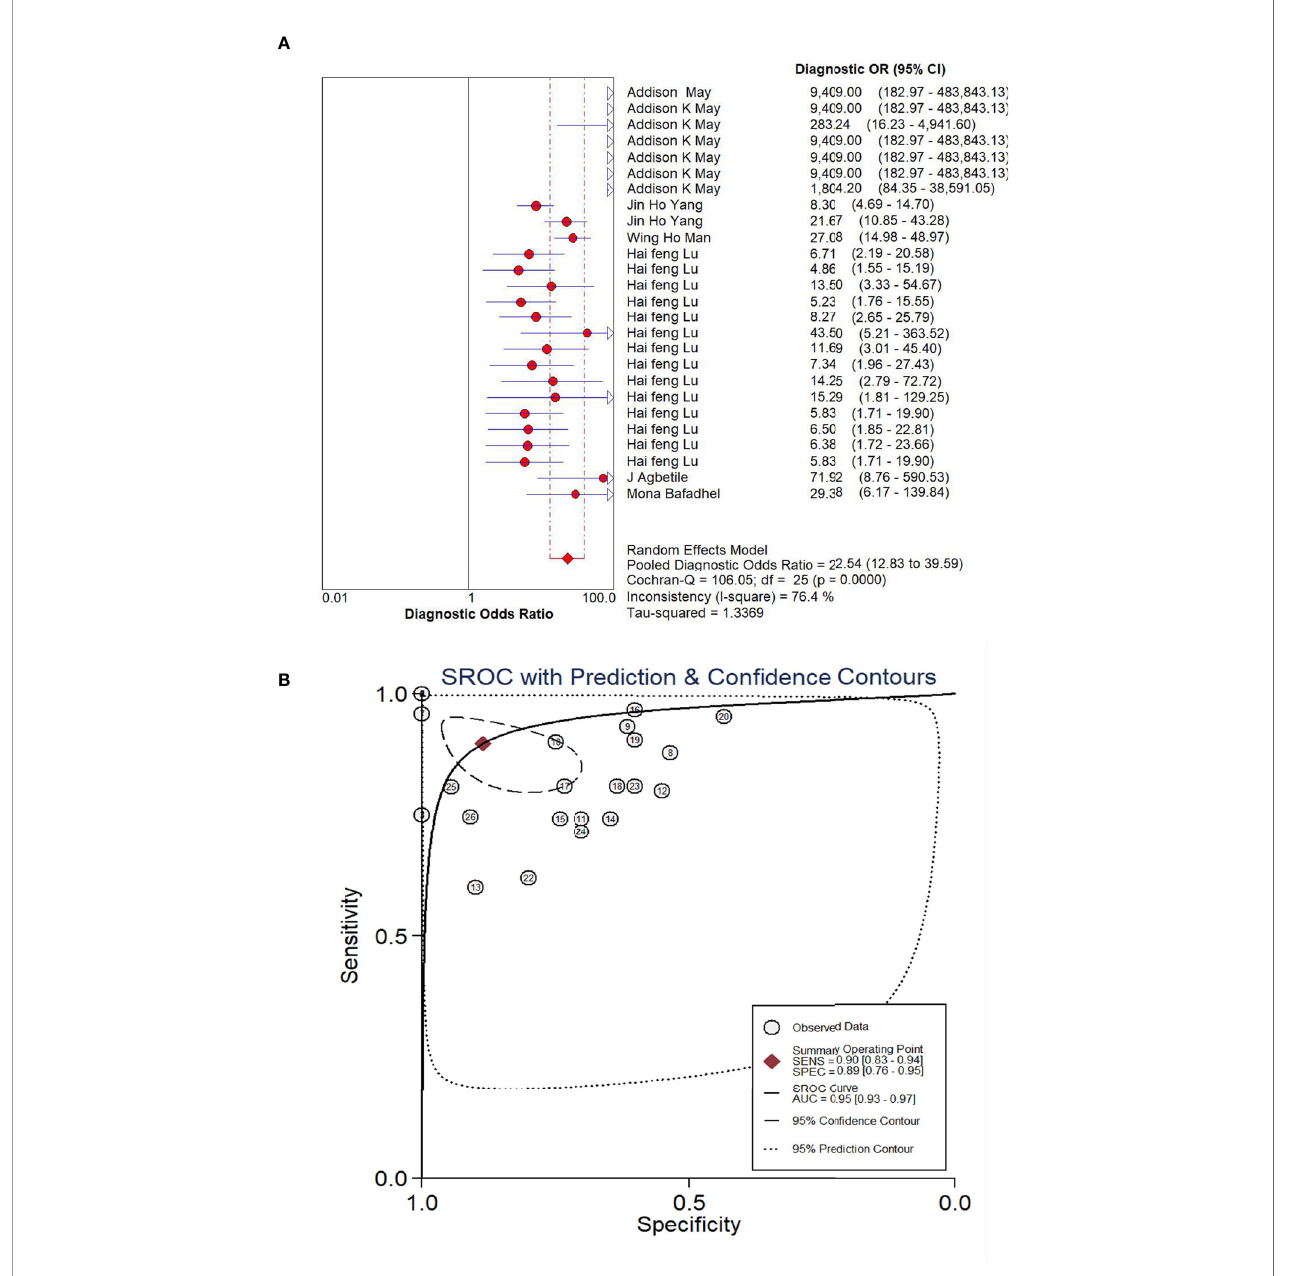
FIGURE 4 | Forest plot of DOR (A) and SROC (B) of microbiota biomarkers for the diagnosis of lung